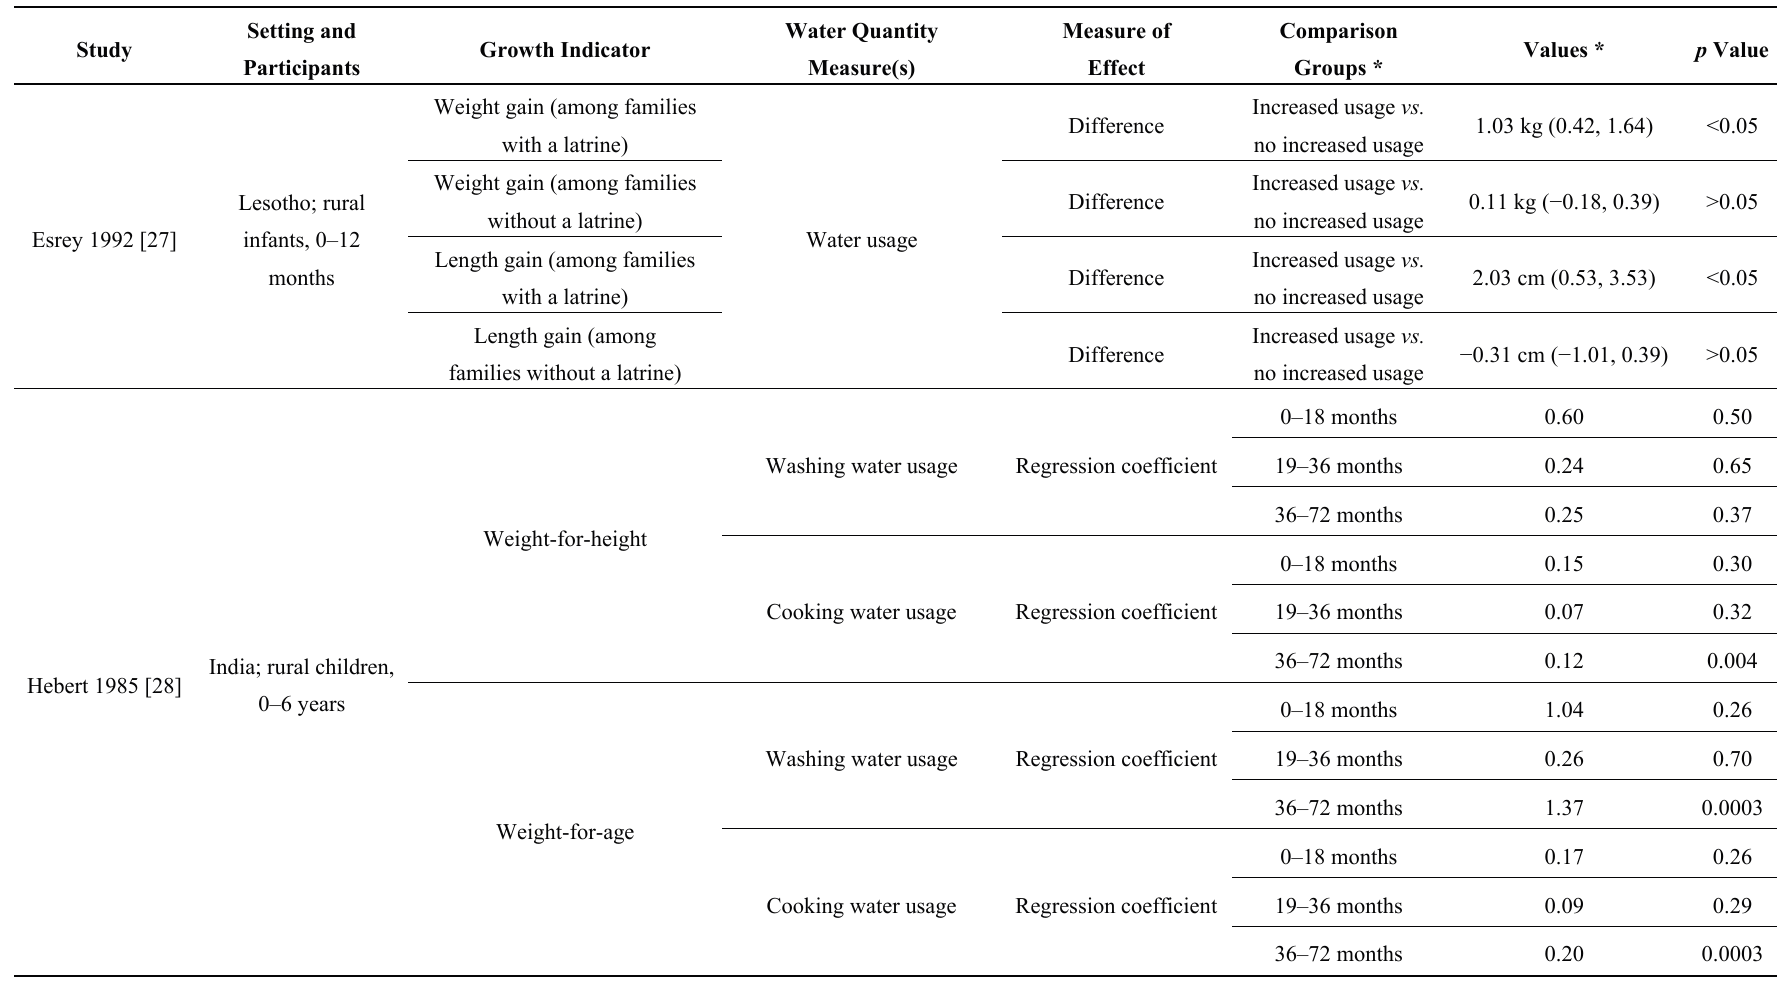
Table 4. Effects of Water Quantity on Growth